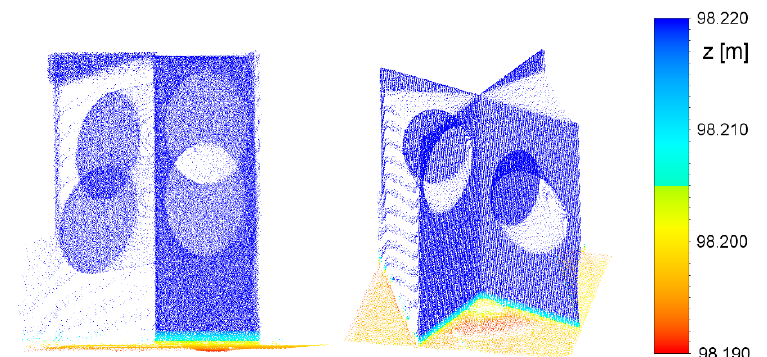
Figure 5. Elongated distances to the points on the black part of the horizontal plane.